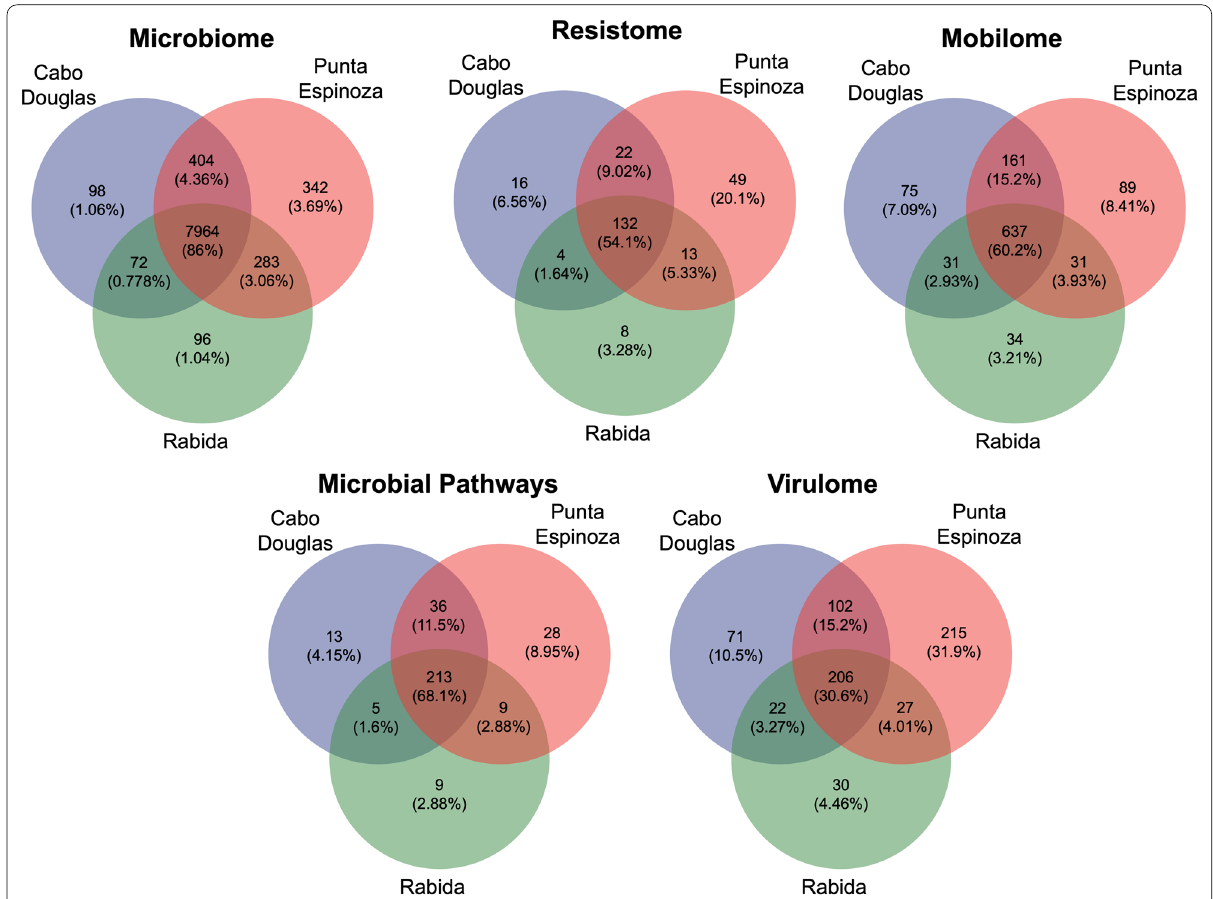
Fig. 11 Core metagenome composition of feces from marine iguanas from three